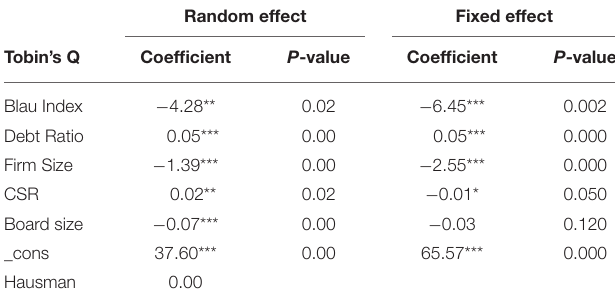
TABLE 6 | Moderating effect of CSR.